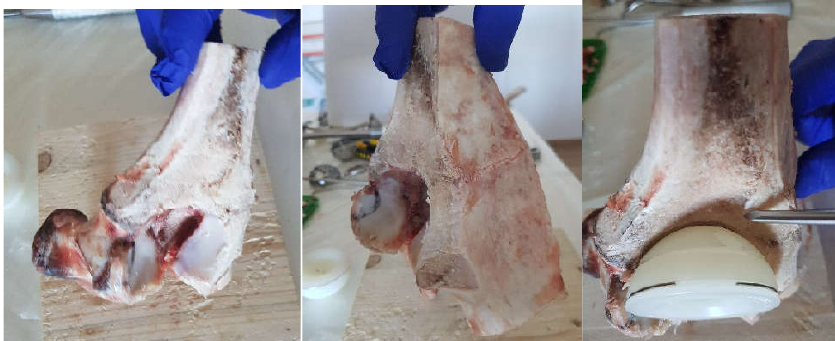
Figure 9. Removing marked areas and positioning the polyethylene cup.